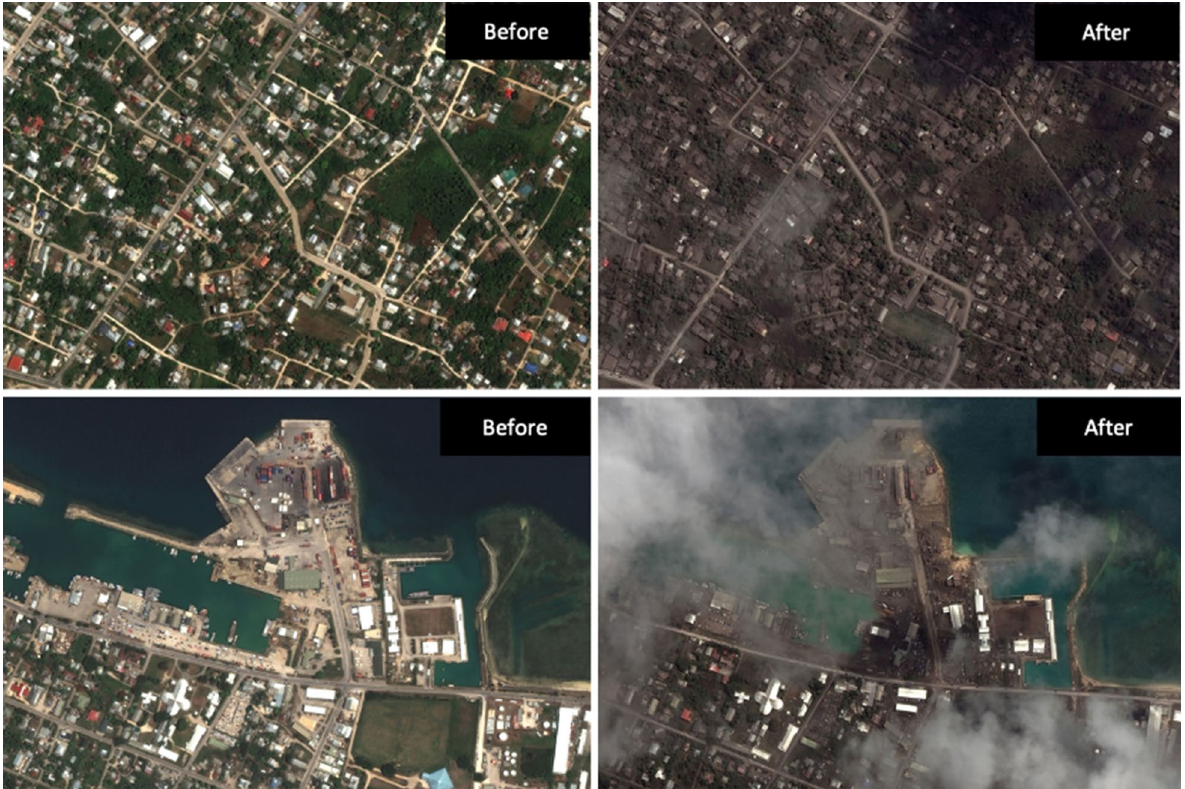
Fig. 7 Homes and buildings in Nuku’alofa on 29 December 2021 (upper left) and on 18 January 2022 (upper right); Main port facilities in Nuku ʻ alofa before (lower left) and after (lower right)